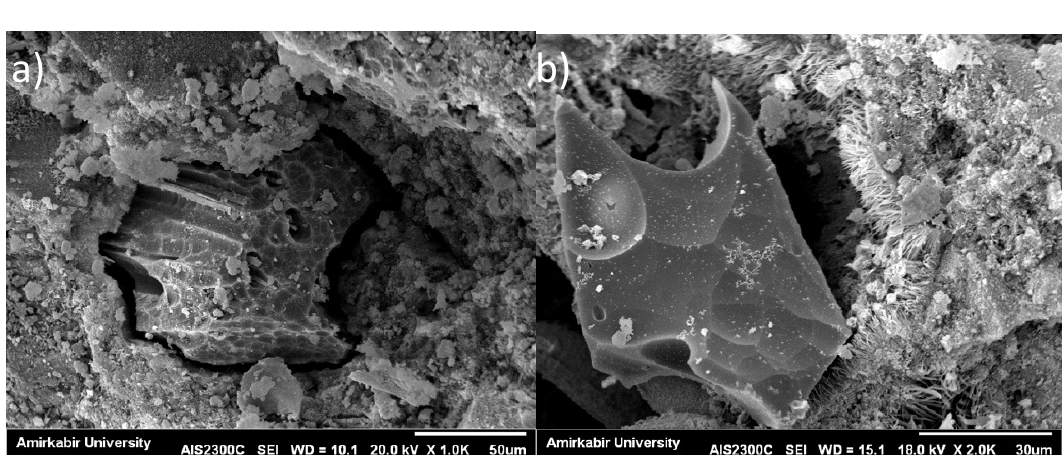
Figure 11. SEM image of (a) PP; (b) PP-MK10NC3.